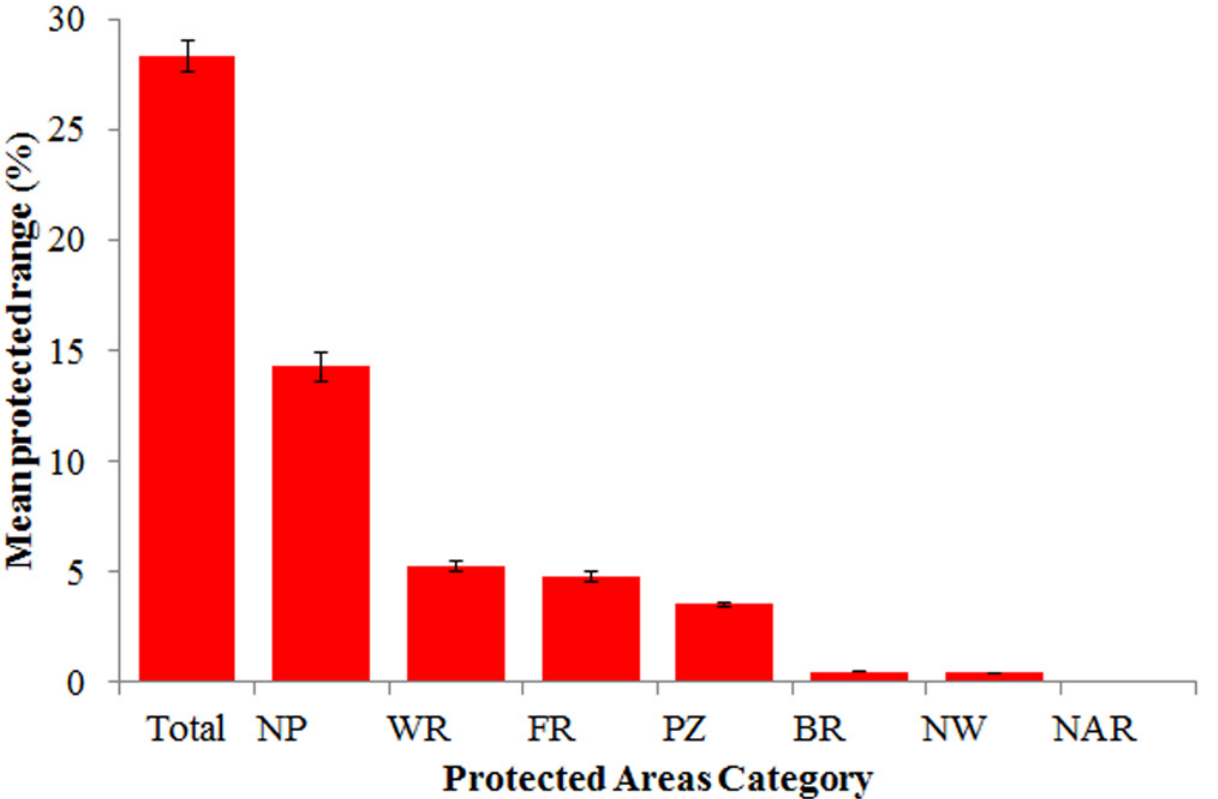
Fig 5. Percentage ( ± SE) of mammal species ranges within protected areas in Costa Rica. Mean percentage species ranges protected overall and in National Parks (NP), Wildlife Refuges (WR), Forest Reserves (FR), Protected Zones (PZ), Biological Reserves (BR), National Wetlands (NW) and National Absolute Reserves